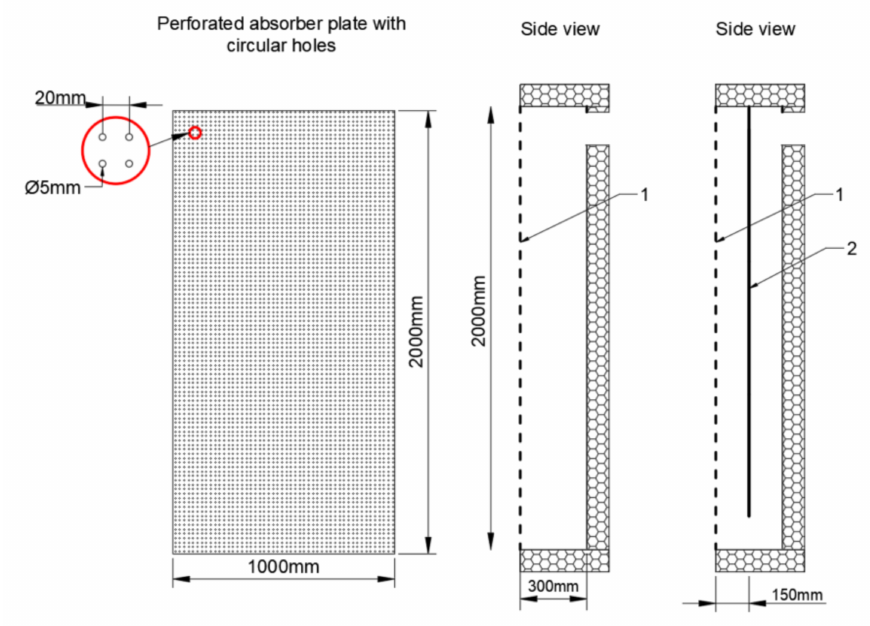
Figure 2. Scheme of the TSC ( left ) and DSTSC ( right ). 1. Perforated absorber plate made of aluminium with black coating. 2. Separation plate made of